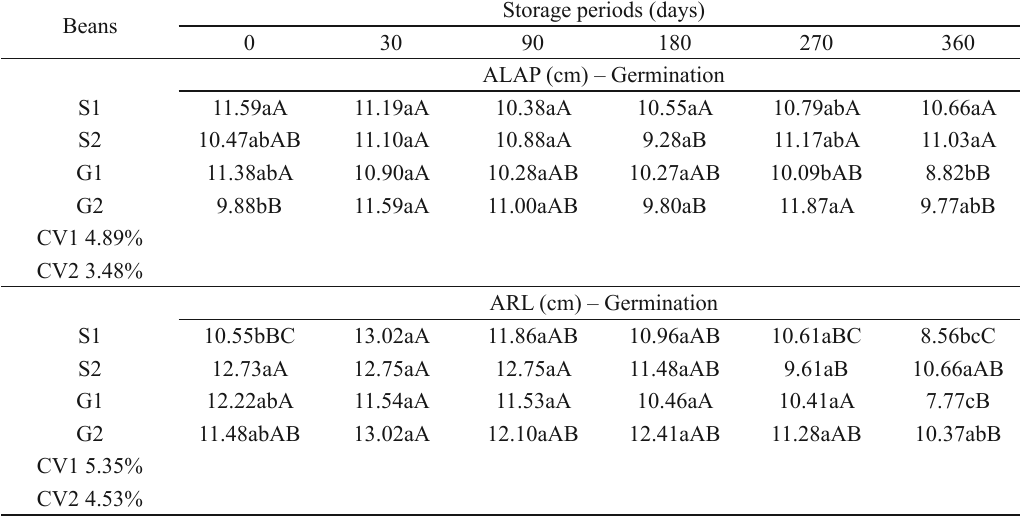
Means followed by case letter: comparison between columns and rows differ between them by Tukey test (5% of signi fi cance). S1 and G1 seeds and grains from fi eld 1, S2 and G2 seeds and grains from fi eld 2,